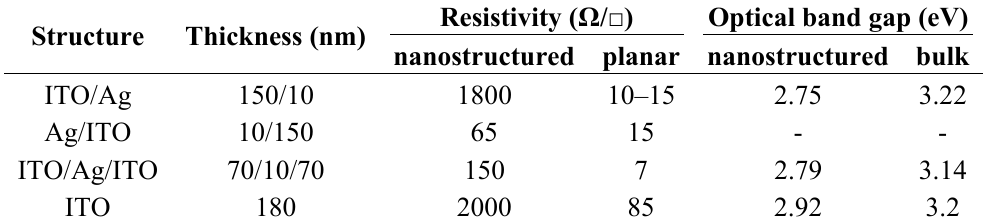
Table 1. Electrical and optical characteristics of different core shell